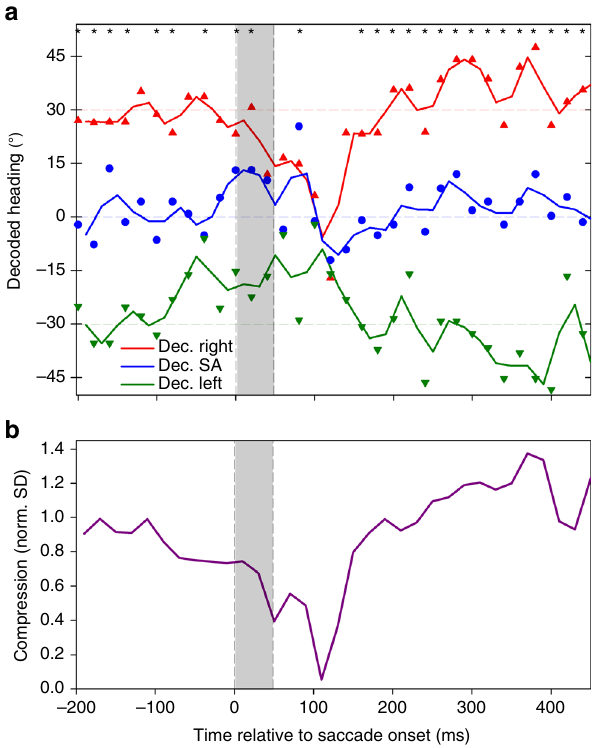
Fig. 2 Decoded heading. a Colored symbols indicate the decoded heading from the neuronal population ( n = 71) for stimuli simulating movement to the left ( − 30°, green, downward pointing triangles), straight ahead (0°, blue, circles), and to the right ( + 30°, red, upward pointing triangles). Data are aligned to saccade onset. The solid lines (colored as the symbols) represent a running mean, based on the average values of decoded heading in two consecutive 20 ms bins, assigned to the time-point centered between the two samples. Asterisks indicate decoded heading values that were signi fi cantly different from each other (ANOVA on ranks, 2 df, P < 0.05, FDR-corrected). One-hundred ten milliseconds after saccade onset, compression toward straight ahead was at maximum, with decoded values being close to zero for all three headings: leftward heading ( − 30°) → decoded heading: − 9.0°; forward heading (0°) → decoded heading: − 6.7°; decoded headings were again signi fi cantly different from each other (ANOVA on ranks, 2 df, P < 0.05, FDR-corrected). b Normalized standard deviation of the three decoded headings (from the raw data values) in steps of 20 ms as measure of the dynamics of perisaccadic